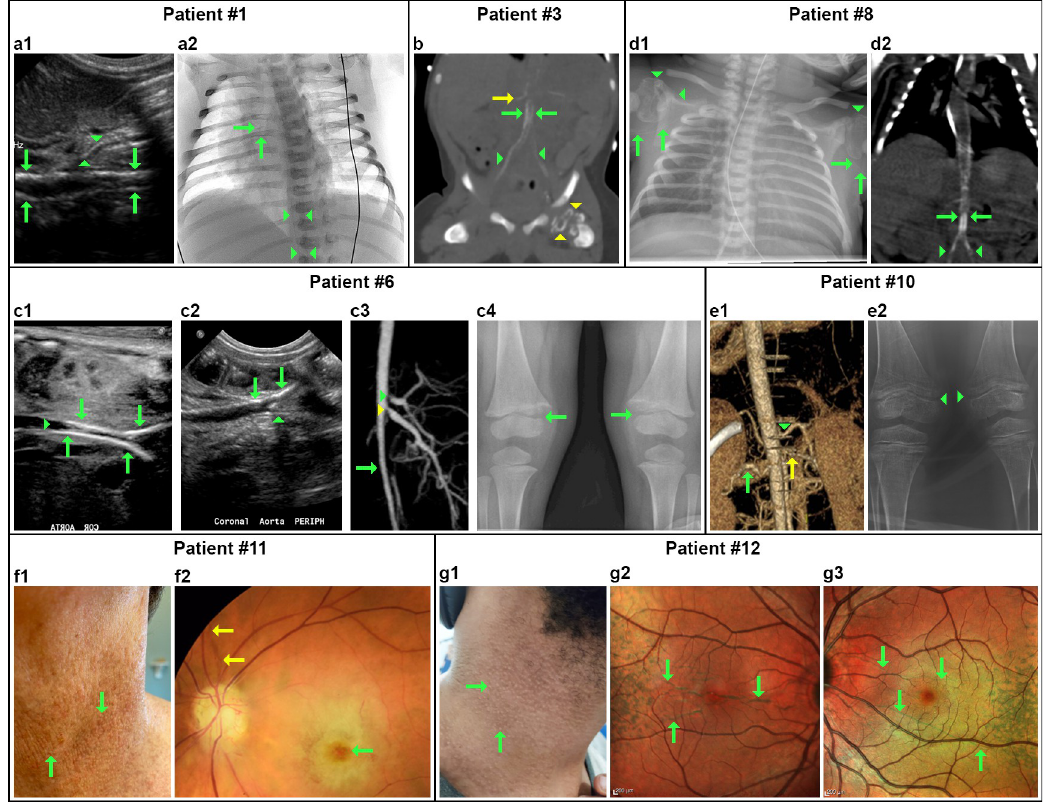
Fig 2. Clinical features in individuals with GACI and/or hypophosphatemic rickets, or PXE. Patient #1: ( a1 ) Prenatal ultrasound of the upper abdomen at 35 weeks of gestation showed calcification along the wall of the aorta (green arrows) and proximal superior mesenteric artery (green arrowheads); ( a2 ) Chest X-ray (inverted) at three days after birth showing calcification in the right pulmonary artery (green arrows) and subtle circumferential calcification throughout the descending and abdominal aorta (green arrowheads). Patient #3: ( b ) Three days after birth CTA showed extensive calcification of the abdominal aorta (green arrows) extending into bilateral iliac arteries (green arrowheads) and right renal artery (yellow arrow). There is also abnormal calcification of the left proximal femoral epiphysis (yellow arrowhead). Patient #6: ( c1 ) Fetal ultrasound at 28 weeks of gestation showed extensive circumferential calcification involving the mid to distal aorta extending to the common iliac arteries (green arrows) with luminal narrowing (green arrowhead); ( c2 ) Coronal ultrasound at 14 days of age showed reduced calcification now limited to the aortic bifurcation (green arrows) and the common iliac arteries (green arrowhead); ( c3 ) At four months of age CTA showed stenosis of the abdominal aorta (green arrow), celiac (yellow arrowhead) and superior mesenteric arteries (green arrowhead); ( c4 ) X-ray of both knees at 24 months revealed symmetric widening of the medial distal femoral epiphysis (green arrows). Patient #8: ( d1 ) X-ray showed extensive calcification of both axillary arteries (green arrows) and dystrophic scapular calcification of the shoulders (green arrowheads); ( d2 ) Abdominal CTA showed calcification of abdominal aorta (green arrow) extending into bilateral iliac arteries (green arrowheads). Patient #10: ( e1 ) CTA At 6.5 years of age showed left renal artery stenosis and dilation (green arrow), abdominal aorta stenosis (green arrowhead), and a beaded right renal artery yellow arrow); ( e2 ) X-ray of both knees showed rough cupping of the posterior end of bilateral tibial shaft (green arrowheads). Patient #11: ( f1 ) Pseudoxanthomatous skin lesions on the neck (green arrows) at 57 years of age; ( f2 ) The presence of angioid streaks (green arrow) and cherry red spot (yellow arrow) in the left eye of patient #11. Patient #12: ( g1 ) Pseudoxanthomatous skin lesions on the neck (green arrows) at 27 years of age; ( g2, g3 ) SPECTRALIS Multicolor Tacking Laser Tomography at 23 years of age demonstrated angioid streaks in both eyes (green